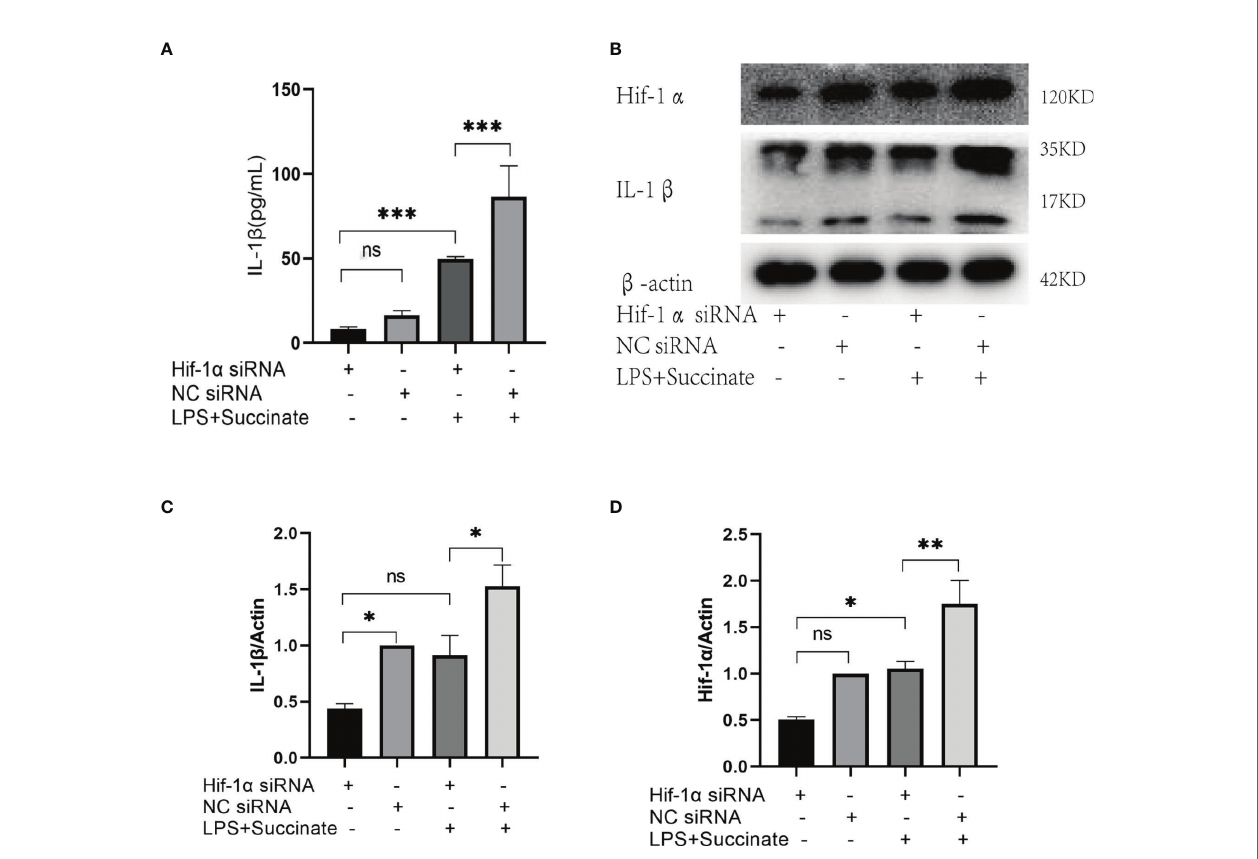
FIGURE 5 | The expression of IL-1 b after Hif-1 a knockout. Hif-1 a siRNA was transfected into HUVECs to downregulate Hif-1 a as follows: Hif-1 a siRNA group, NC siRNA group, Hif-1 a siRNA and LPS+succinate group, NC siRNA and LPS+succinate group. (A) IL-1 b of supernatant medium was detected via ELISA. (B – D) Expression levels of Hif-1 a and IL-1 b were assessed via Western blots. Western blot data present mean ± SEM from three independent experiments at least. ELISA results represent mean ± SD from three different experiments at least. * P < 0.05; ** P < 0.01; *** P < 0.001; ns means no statistical